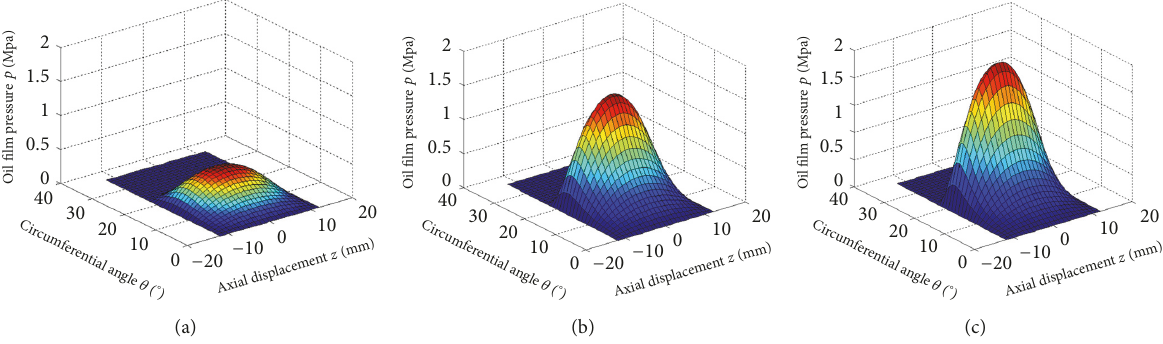
Figure 6: Oil film pressure of sliding bearing II under torque load. (a) 7.2 Nm, (b) 42.4 Nm, and (c) 81.5